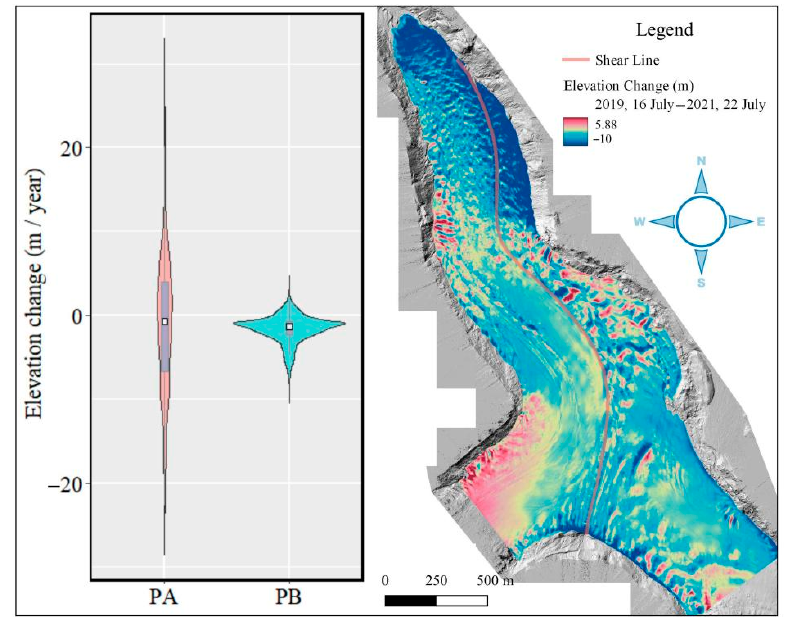
Figure 10. Changes in elevation (PA: 22 July 2018–16 July 2019; PB: 16 July 2019–22 July 2021).